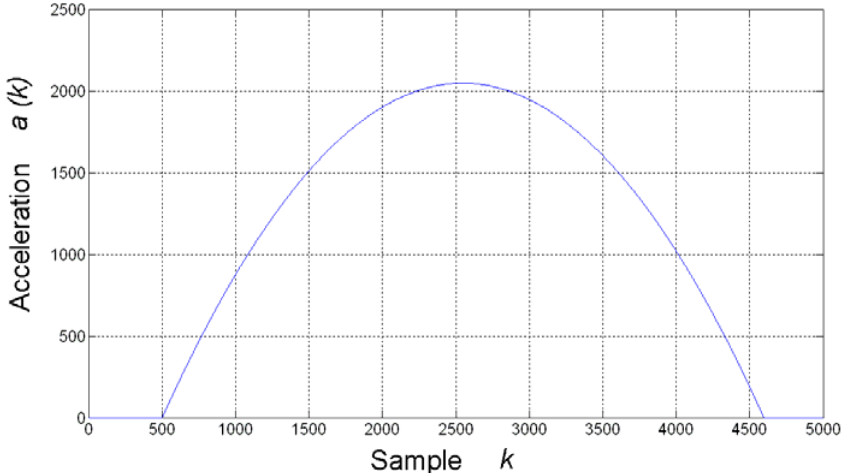
Figure 6. Typical slow-changing quadratic acceleration profile.